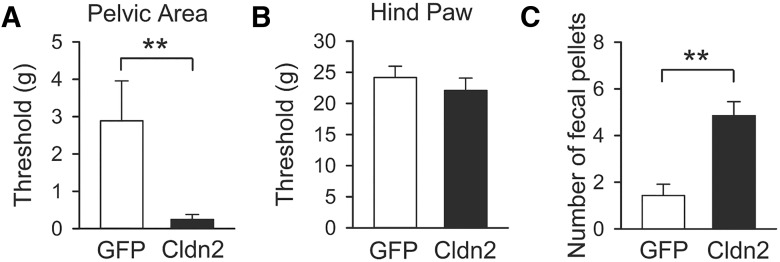
Overexpression of Cldn2 in the urothelium induces pelvic mechanical allodynia and organ cross-sensitization. A, B, Urothelial overexpression of Cldn2 reduces the threshold to mechanical stimuli applied to the pelvic area. Mechanical allodynia on the lower abdominal area close to the urinary bladder (A) and on the plantar surface of the hind paw (B) was evaluated with von Frey filaments in rats transduced with AdGFP or AdCldn2. 50% mechanical withdrawal threshold (g) was estimated with von Frey filaments applied in an up-down testing paradigm as previously described (Chaplan et al., 1994). Statistically significant difference between experimental conditions is indicated as **p < 0.01 (n = 7, Mann-Whitney nonparametric test). C, Urothelial overexpression of Cldn2 sensitizes colon afferents. Number of fecal pellets in a 4 h period in rats transduced with AdGFP or AdCldn2. Statistically significant difference between experimental conditions is indicated as **p < 0.01 (n = 7, Mann-Whitney nonparametric test).